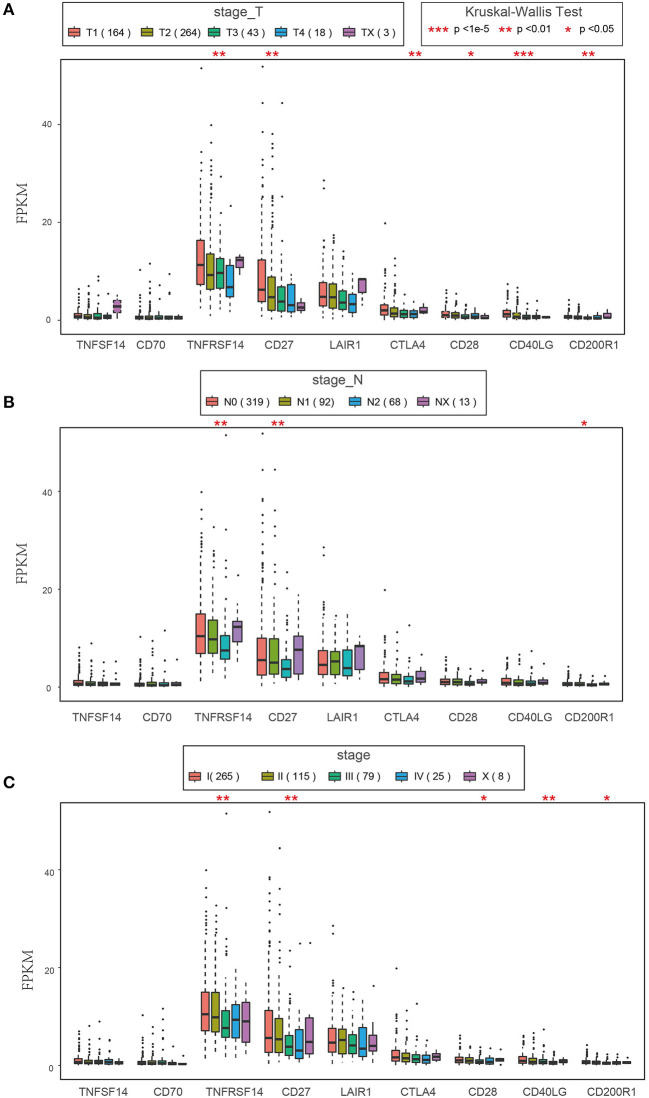
(A) Box diagram of nine ICGs' expression in different T stages (FPKM); (B) Box diagram of nine ICGs' expression in different N stages (FPKM); (C) Box diagram of nine ICGs' expression in different Stages (FPKM). The Abscissa represents the ICGs, and the ordinate represents the expression of ICGs in different T/N/Stages. The test method is Kruskal-Wallis Test. *P < 0.05; **P < 0.01; ***P < 1e-5.